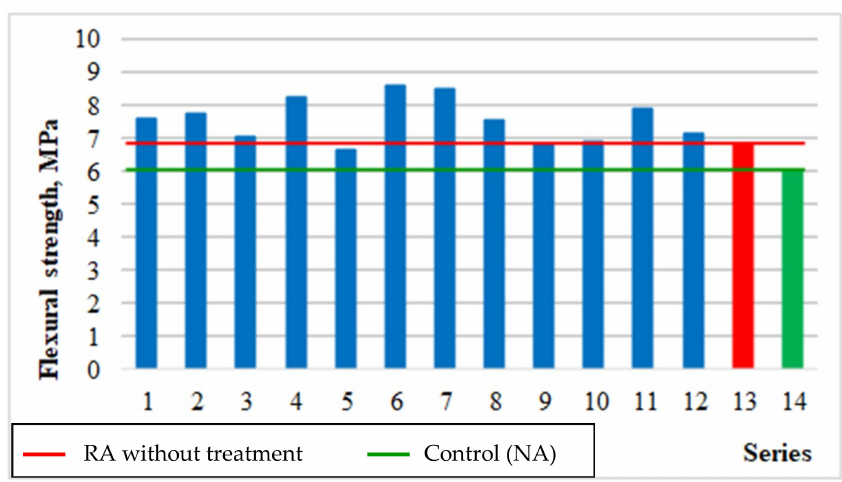
Figure 6. The flexural strength of concretes compared with series 13 and 14.